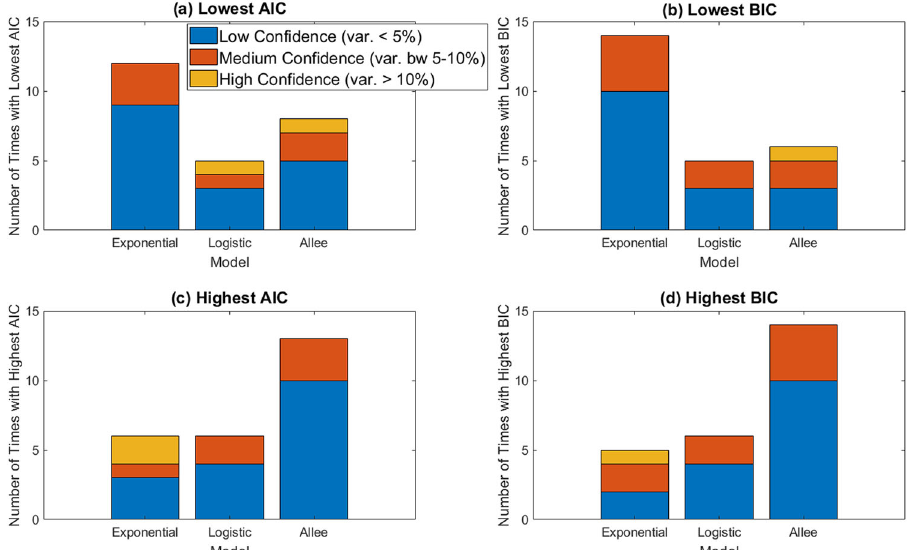
Fig. 3 AIC and BIC comparisons across control models. a , b The number of mice for which each model has the lowest IC value (i.e., is the most parsimonious model), with ( a ) using AIC and ( b ) using BIC. c , d The number of mice for which each model has the highest IC value (i.e., is the least parsimonious model), with ( c ) using AIC and ( d ) using BIC. We have low con fi dence in our classi fi cation (blue) when the IC value corresponding to the most parsimonious (or least parsimonious, for high IC) model varies by 5% or less from the other IC values. We have medium con fi dence (red) when it varies by 5 – 10%, and high con fi dence (yellow-orange) when it varies by